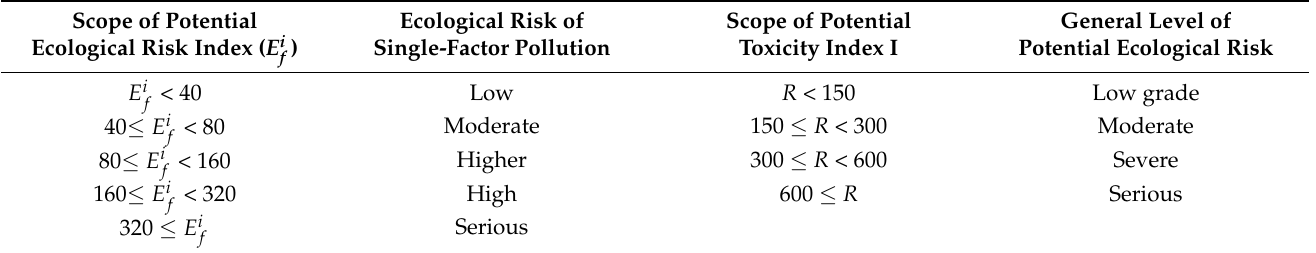
Table 5. Relationship between potential toxicity index I, potential ecological risk index ( E i pollution level